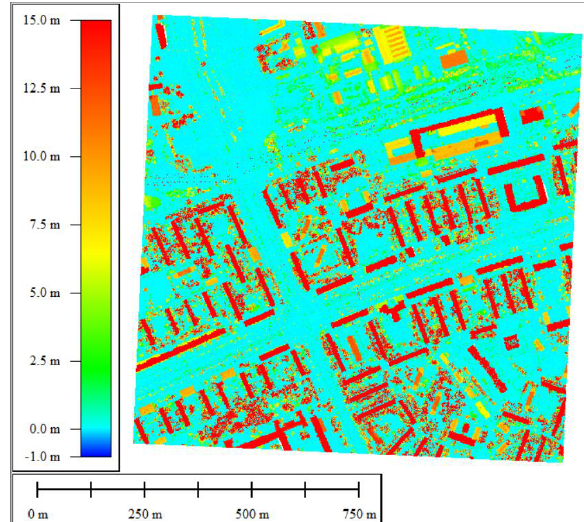
Figure 1. Initial airborne laser scanning point